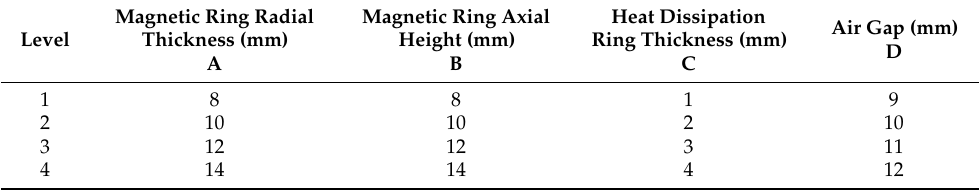
Table 1. Orthogonal design table of level factors.